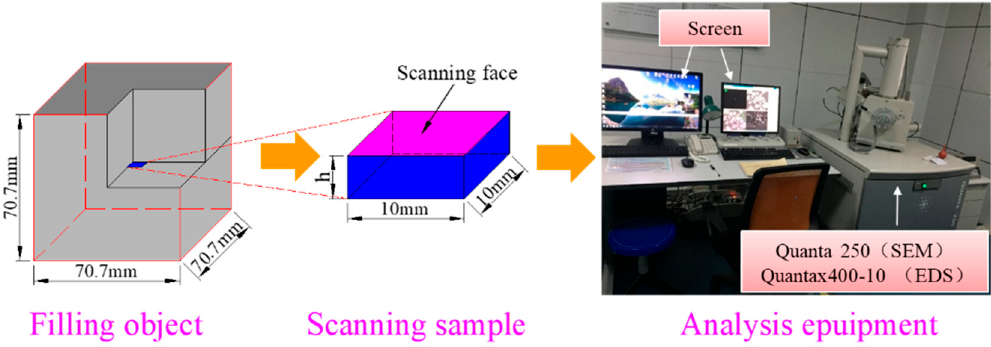
Figure 8. The SEM and EDS scanning sample preparation process and analysis equipment.